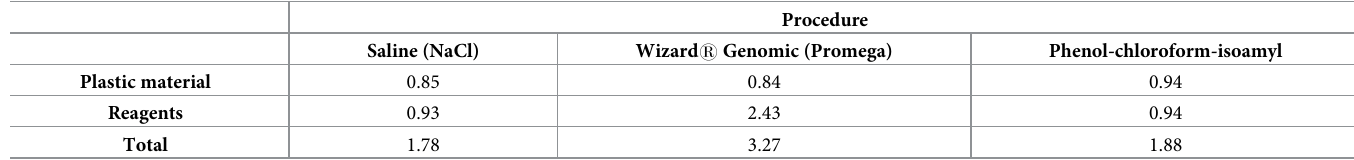
Table 1. Comparison of the costs (in US dollars) required to isolate DNA per sample according to the three DNA extraction